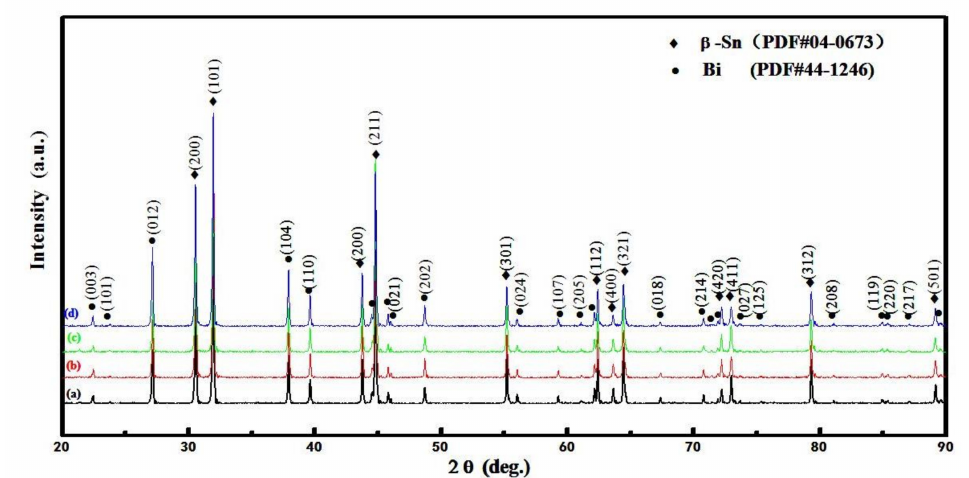
Figure 4. X-rays di ff raction pattern for ( a ) Sn-20Bi, ( b ) Sn-20Bi-0.1Al, ( c ) Sn-20Bi-0.3Al, ( d ) Sn-20Bi-0.5Al Solder alloys.